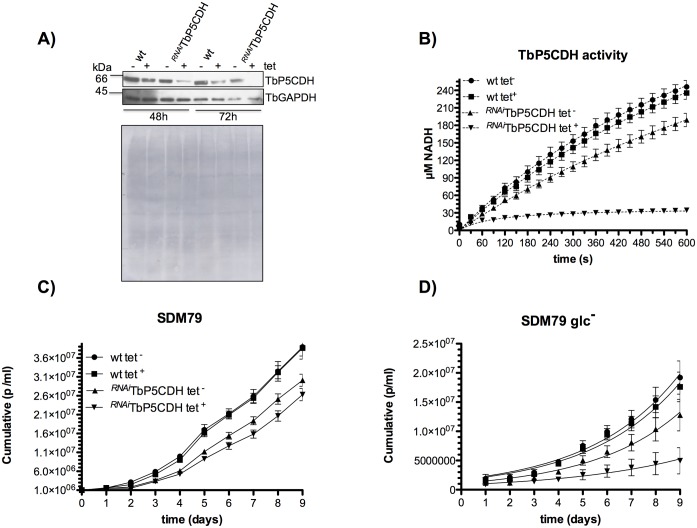
Phenotypic characteristics of TbP5CDH RNAi cells.A) Protein levels of TbP5CDH and TbGAPDH after three days of tetracycline-induction. Comparisons were made between non-induced (tet-) and tet-induced (tet+) from both wt and RNAiTbP5CDH mutant cells. Cell lysates (30 μg of total protein per lane) were loaded and probed with antibodies as indicated before. Protein loading controls were verified by nigrosine staining of the PVDF membrane after probing with specific antibodies. B) TbP5CDH activity was determined after three days of tetracycline-induction in wt and RNAi-induced cells. Cell-free total lysates were prepared from PCF trypanosomes and used as enzyme samples. Steady-state rates were monitored spectrophotometrically (Abs340nm) using 200 μg of each lysate to start the reaction. C-D) Growth curves of wt tet-/+ and RNAiTbP5CDH tet-/+ PCFs. Parasites (106 cells/ml) were grown in standard SDM79 (C) or SDM79 glc- (glucose-depleted) (D) selective media. Cell densities were determined daily and were split into fresh medium every 72h. Plots represent cumulative cell numbers determined over a period of 9 days.